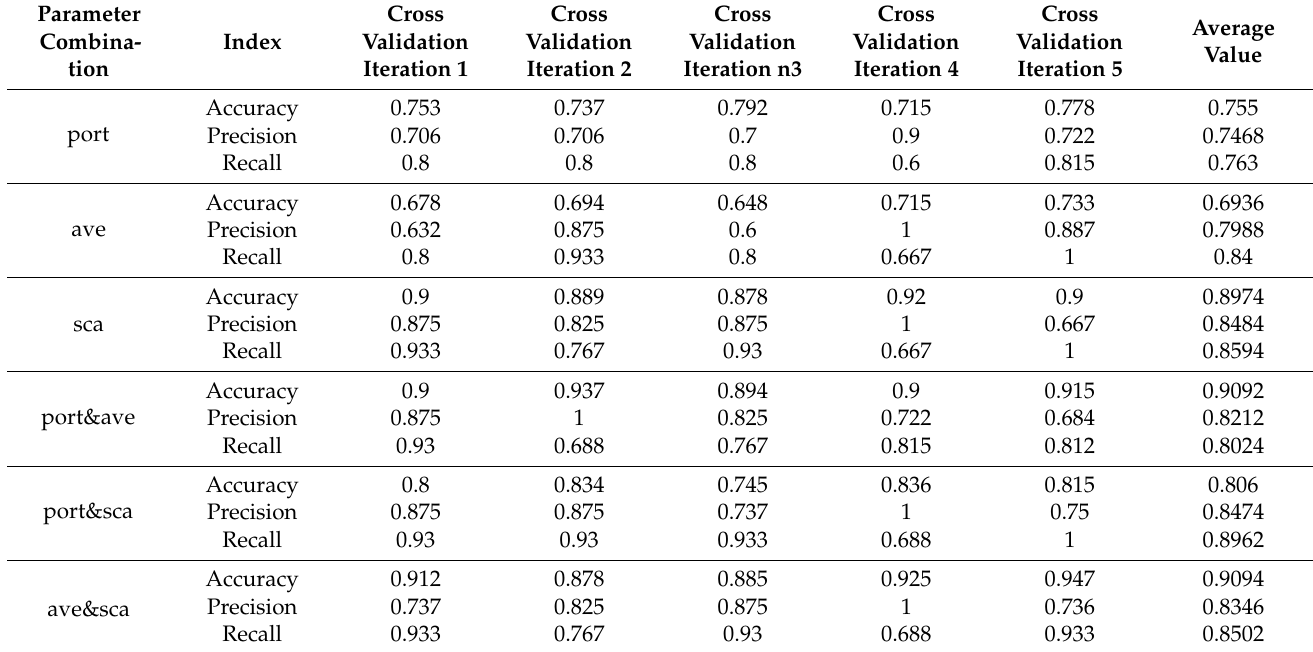
Table 9. Index of the classification of human fall postures with single and combined